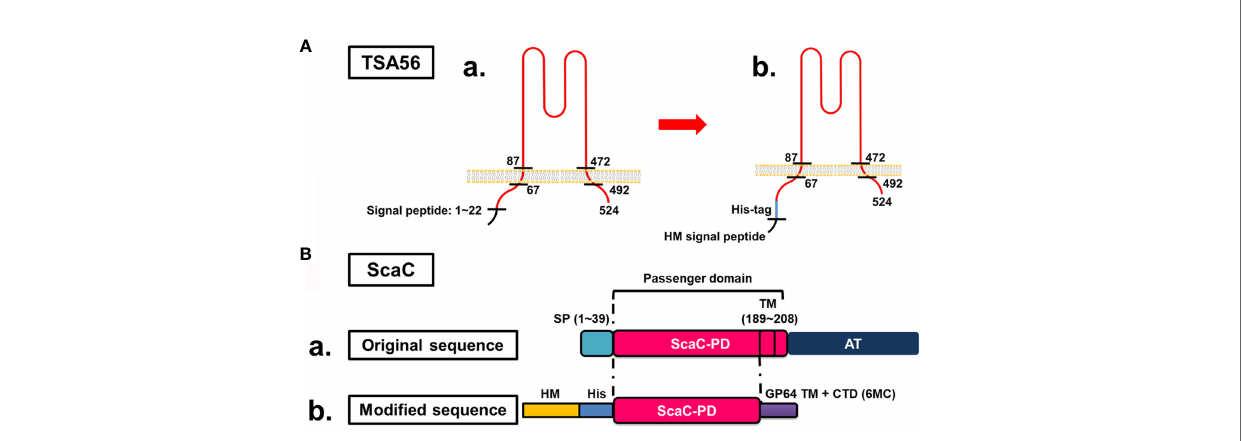
FIGURE 1 | Cloning strategies for surface display of recombinant TSA56 and ScaC-PD using a baculovirus-insect cell system. (A) Structure and strategy for displaying TSA56 protein on Sf21 cells. (A-a) TSA56 protein has a signal peptide from residues 1 to 22 and two TM domains (residues 67 to 87 and 472 to 492, respectively). (A-b) The signal peptide was replaced by an HM signal peptide and a His-tag, but the rest of the protein was preserved. (B) Structure and strategy for displaying ScaC-PD on Sf21 cells. (B-a) ScaC contains a signal peptide (SP), a passenger domain (PD), and an autotransporter (AT) domain. (B-b) The signal peptide (SP) was replaced by an HM signal peptide (HM) and a His-tag (His), and the TM-truncated passenger domain was fused with the TM and cytoplasmic-tailed domain (CTD) of GP64 protein (6MC) from